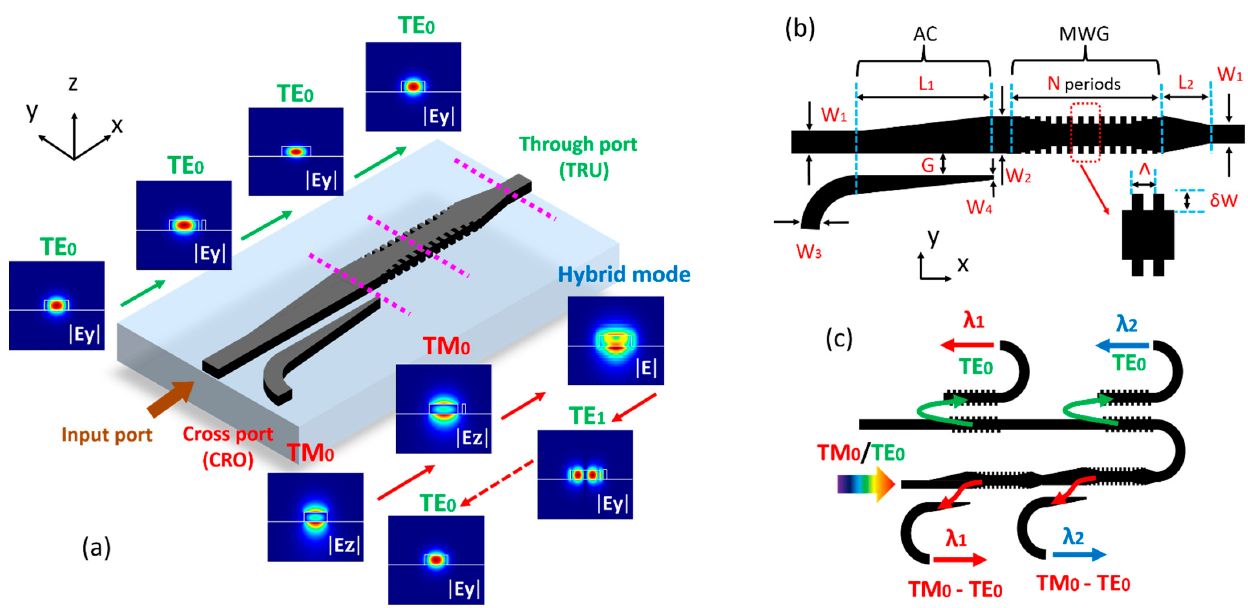
Figure 1. Schematic configuration of the proposed PSR. ( a ) Three-dimensional structure and ( b ) top view of the device. ( c ) Architecture of polarization insensitive wavelength duplexer based on MWG-based PSRs and contra-DCs. The structure parameters of width, period, grating number, and corrugation width in the uniform MWG region are denoted by W 2 , ᴧ , N, and δ w, respectively, as labeled in